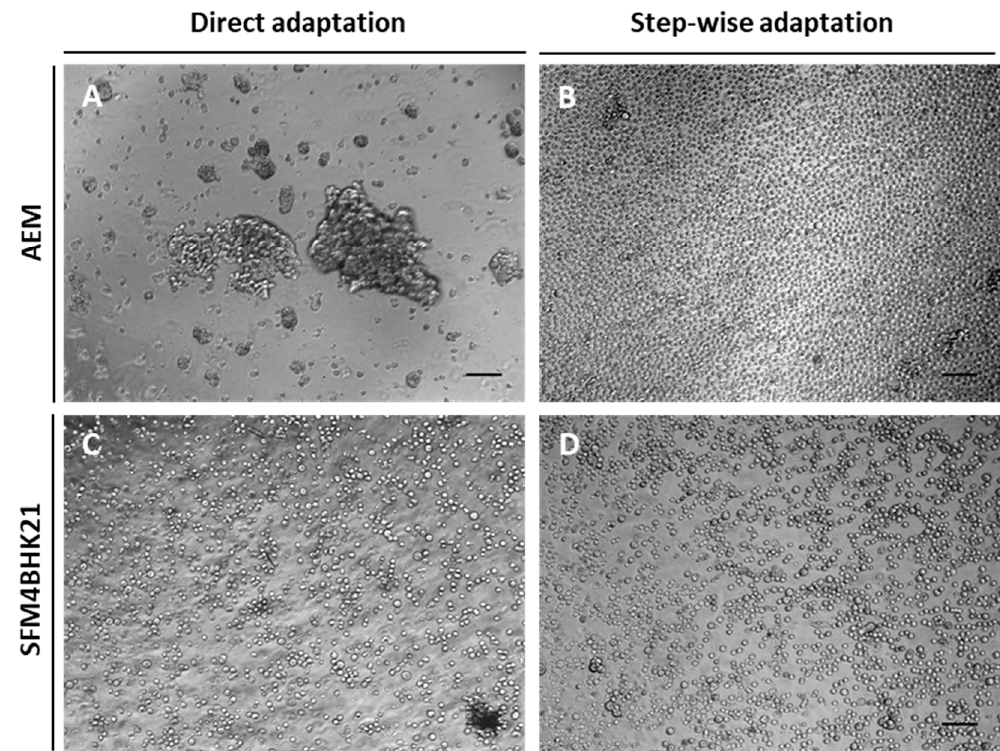
Figure A1. Morphology of MDCK cells from ATCC after adaptation to suspension. Cells were adapted to one of two serum-free culture media—AEM or SFM4BHK21—following a direct approach ( A , C ) or a stepwise approach ( B , D ). Cells were analyzed and digitally visualized as described in Figure 1. Scale bar—100 μ m.